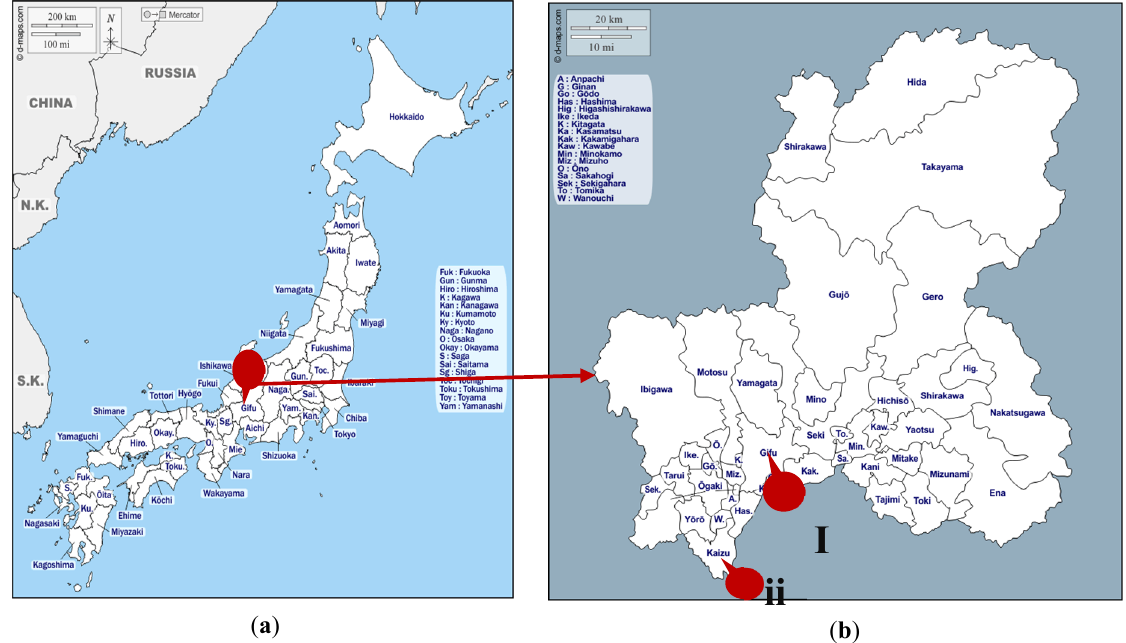
Figure 1. Experimental locations in Japan: ( a ) Gifu city is shown on a map of Japan; ( b ) the research field of Gifu University and farmer’s field of Kaizu city are shown on a map of Gifu. The original maps are available from d-maps [26].